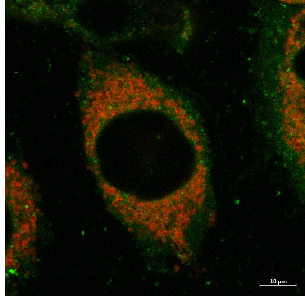
Figure 8. Fluorescent imaging with fluorescent conjugate 12 (ex/em: 488/520 nm) double-stained with MitoTracker TM Deep Red (ex/em: 596/615 nm) in PC3 cancer cell line.